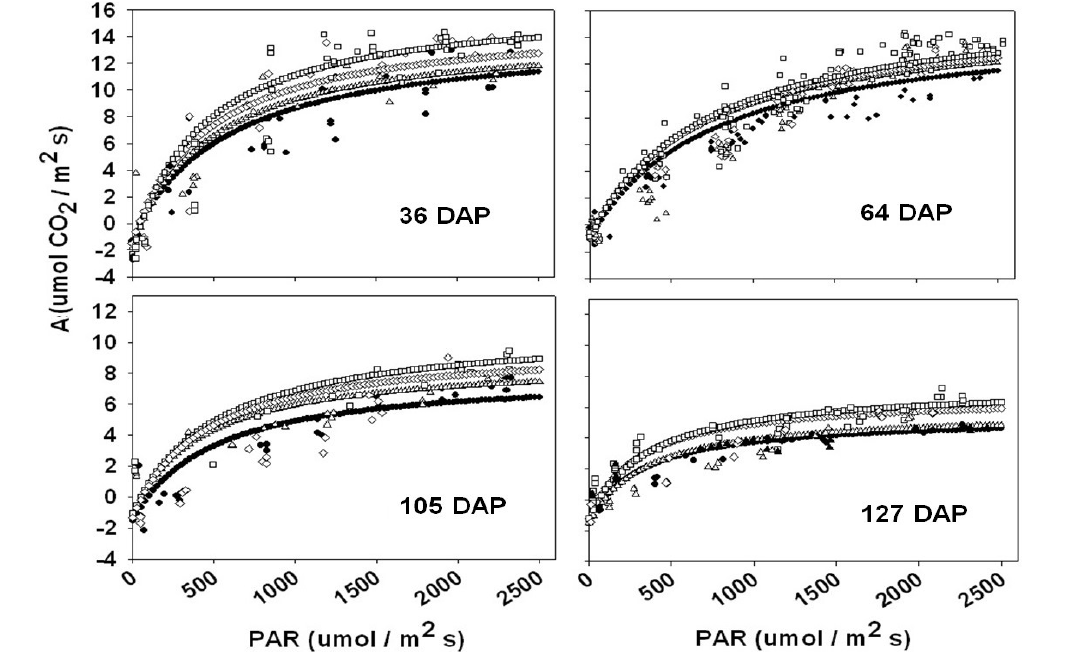
Figure 1. Leaf photosynthesis- photosynthetically active radiation (PAR) response curves. A is the net carbon assimilation rate during days after planting (DAP) in the different treatments of nitrogen fertilization: (●) 0, (∆) 100, (◊) 200 and (□) 300 kg N ha -1 .